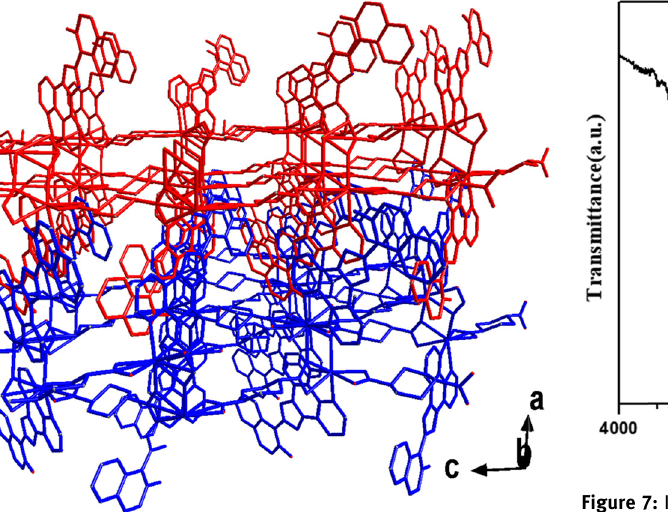
Figure 5: View of the 3D supramolecular structure of 1 formed by π – π interactions.